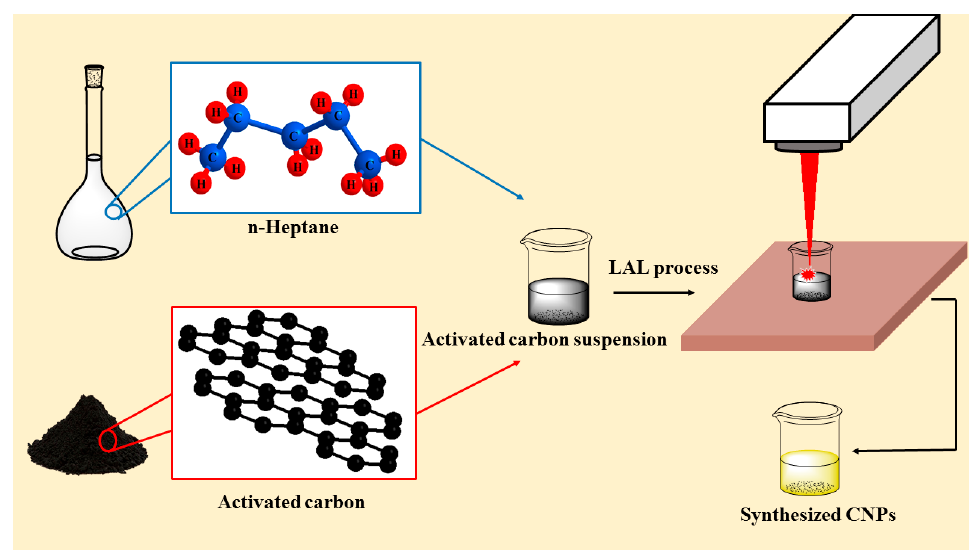
Figure 1. Schematic representation of the adopted experimental procedure for preparation of CNPs.